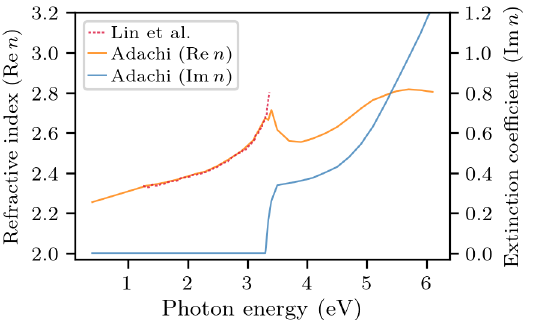
Figure 4. The real and imaginary parts of the refractive index of undoped GaN. The data are taken from Lin et al. [23] and Adachi [24]. In our analysis, we will be using Adachi’s